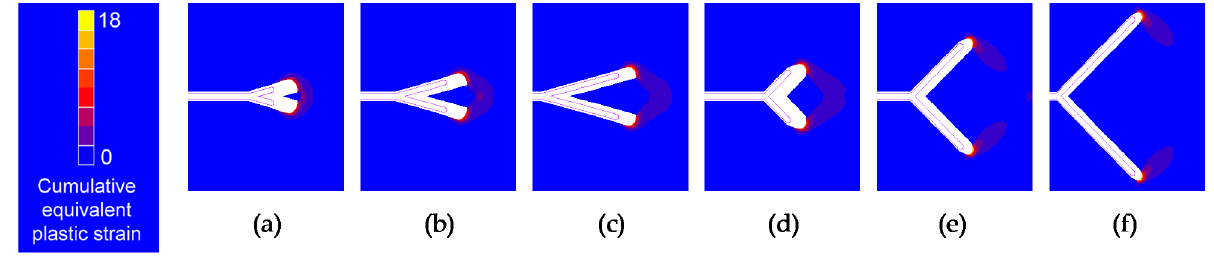
Figure 12. Initial and final crack tip profile and cumulative equivalent plastic strain in the symmetric case with Δ K = 31.25 MPam 1/2 : ( a ) α = 15°, l ´ = 25 µm; ( b ) α = 15°, l ´ = 50 µm; ( c ) α = 15°, l ´ = 75 µm; ( d ) α = 45°, l ´ = 25 µm; ( e ) α = 45°, l ´ = 50 µm; ( f ) α = 45°, l ´ = 75 µm.